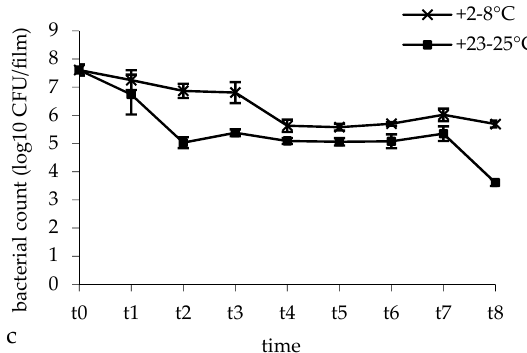
Figure 3. L. brevis CD2 survival in the buccal films during a storage period of 48 weeks at the temperatures of +2–8 °C and +23–25 °C. t0: time zero; t1: 2 weeks; t2: 4 weeks; t3: 8 weeks, t4: 12 weeks; t5: 24 weeks; t6: 36 weeks; t7: 48 weeks. ( a ) Batch I; ( b ) batch II; ( c ) batch III. Data are expressed as mean of four measurements ± standard deviation.